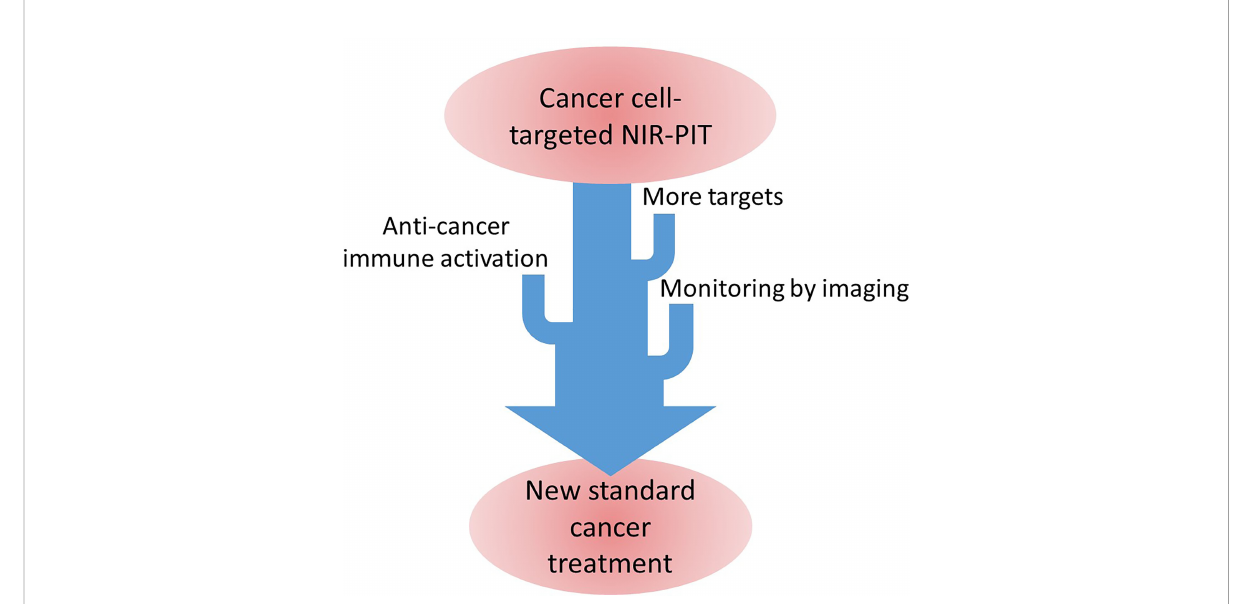
FIGURE 1 Diagram of our current progress plan of the NIR-PIT toward the standard cancer